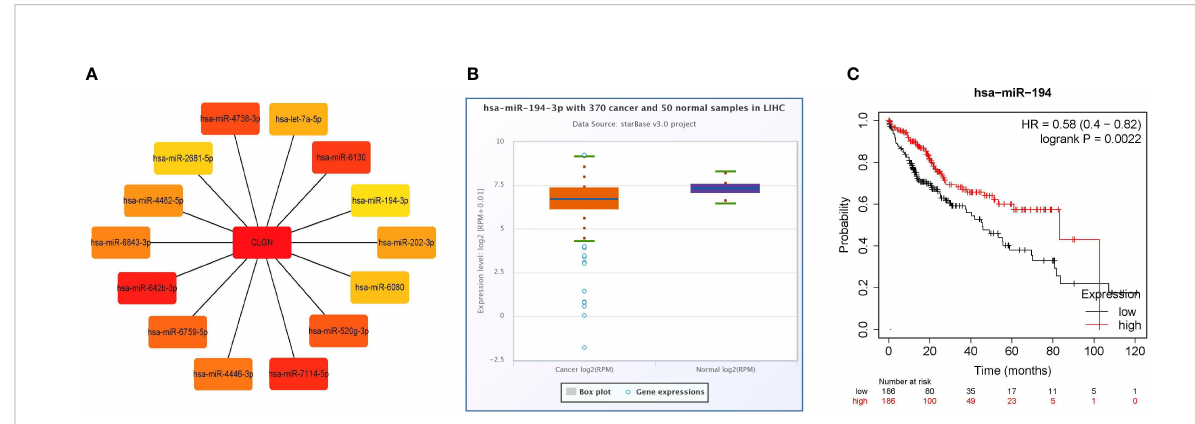
FIGURE 9 miRNAs that likely regulate the expression of CLGN mRNA (miRWalk and TargetScan). (A) The 14 miRNAs that most closely related to CLGN mRNA. (B) The expression of hsa-miR-194-3p in HCC is signi fi cantly lower than in normal tissue, p < 0.05 (ENCORI). (C) HCC patients with lower hsa-miR-194 expression have poorer OS than those without, p < 0.05 (Kaplan Meier